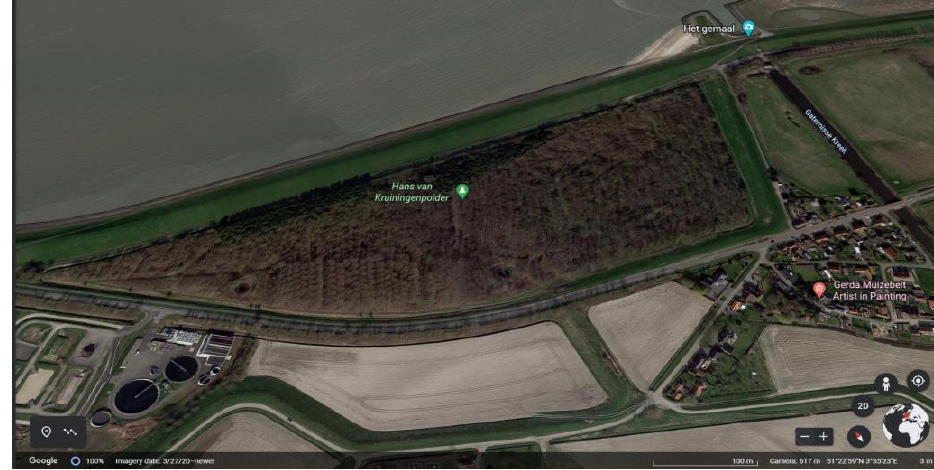
Figure 2. The Grazing Field.